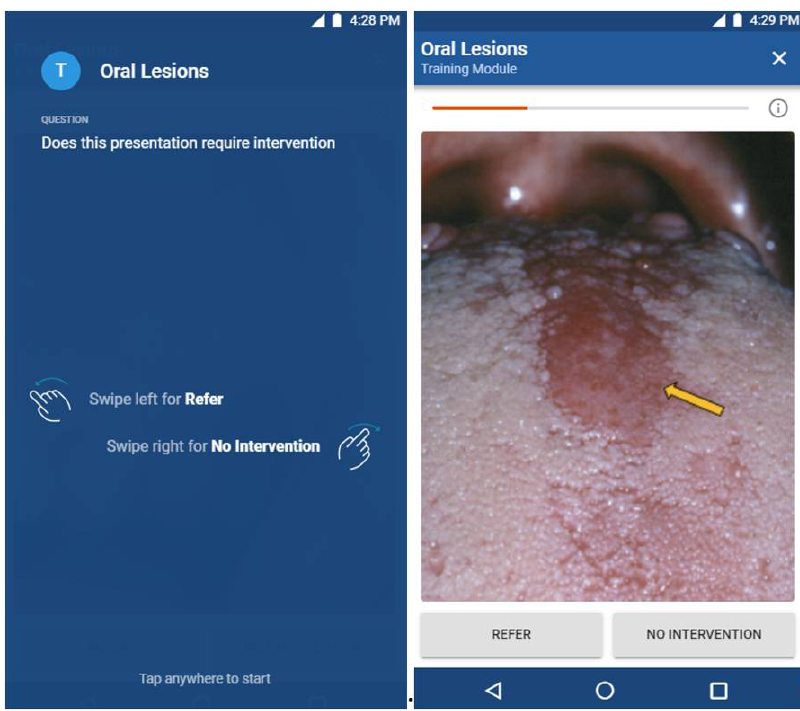
Figure 3. Screen captures of the student interface.